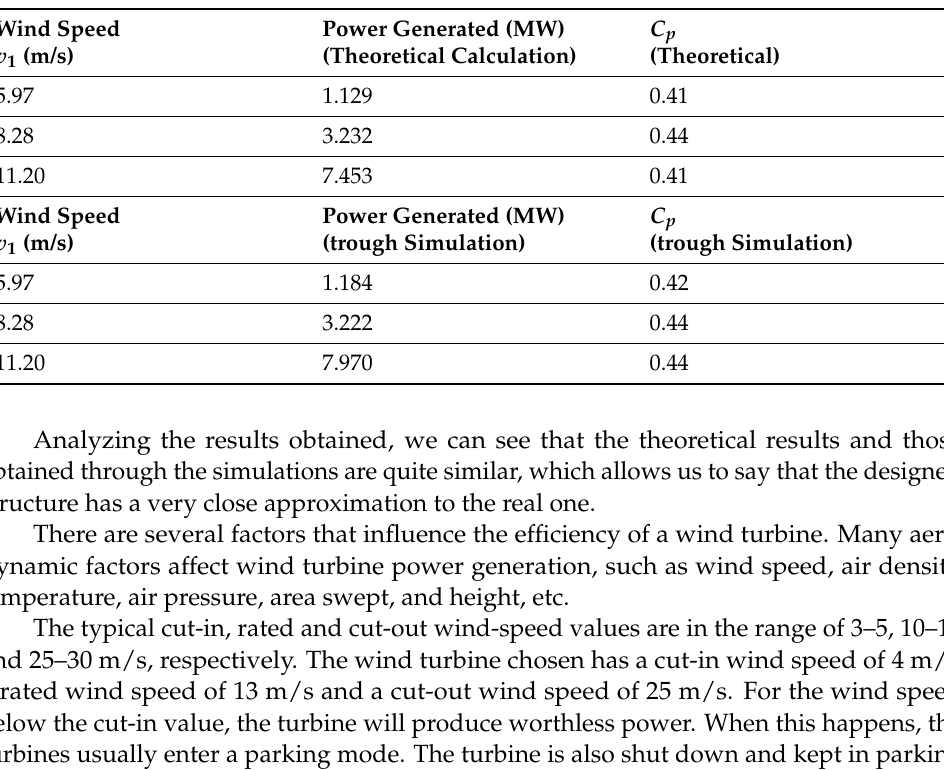
Table 12. Comparison of theoretical and simulated